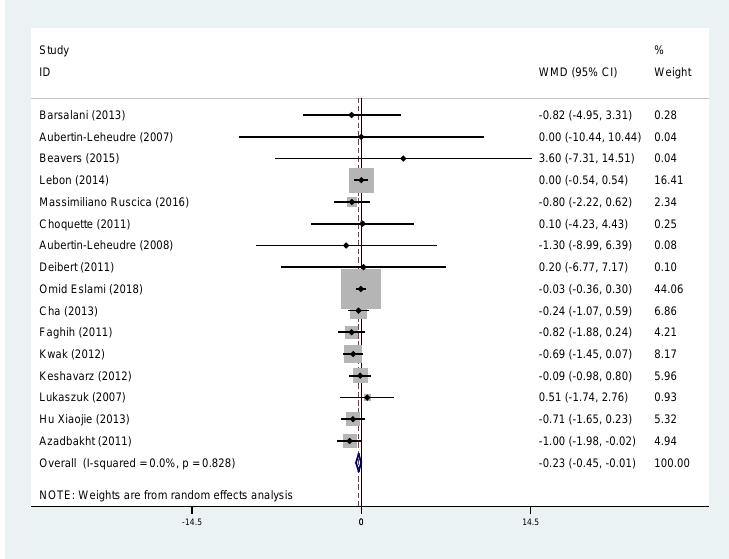
Figure 4. Meta-analysis of the effect of soy products on body mass index (BMI). ID: identification; WMD: weighted mean difference.